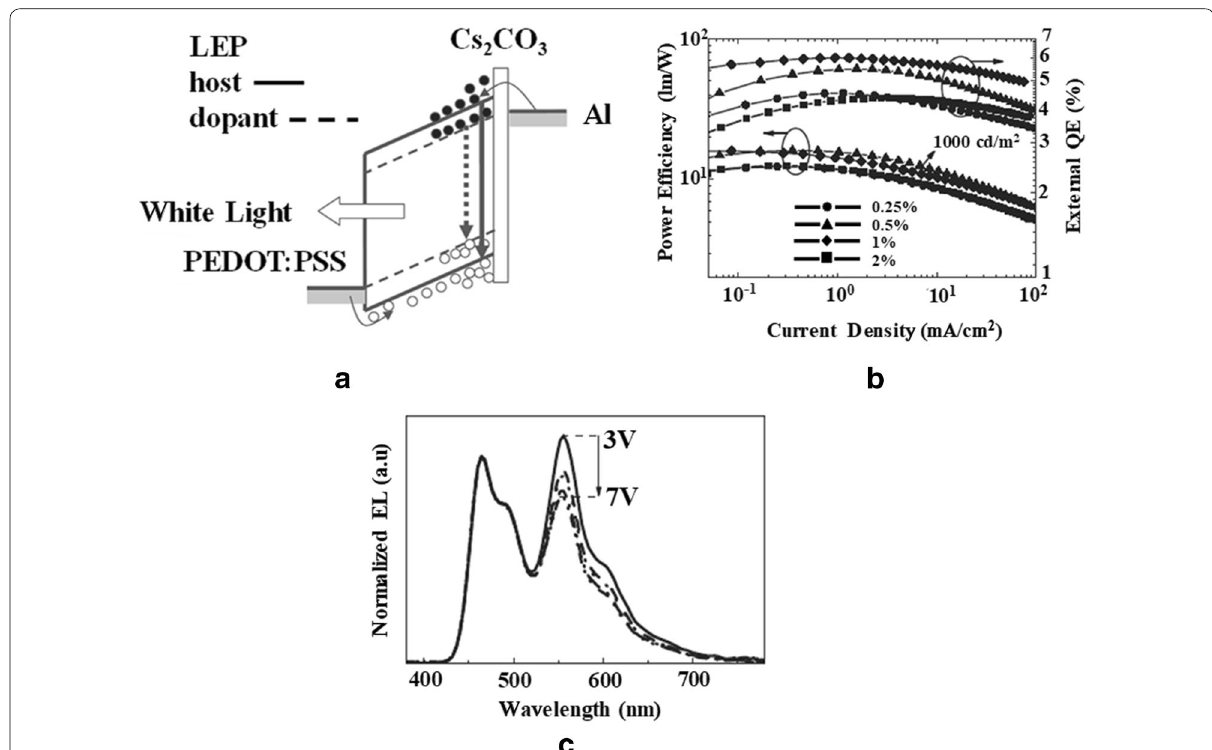
Fig. 6 a Schematic energy band diagram of the WPLED. b External efficiency and power efficiency for the PLEDs with different doping ratio as functions of current density and c normalized EL spectra of MEH-PVV: PFO (0.25 wt%) PLED at different applied voltages (3 to 7 V) (Reproduced with permission from [23] Copyright 2006, ©WILEY–VCH Verlag GmbH &amp; Co. KGaA,